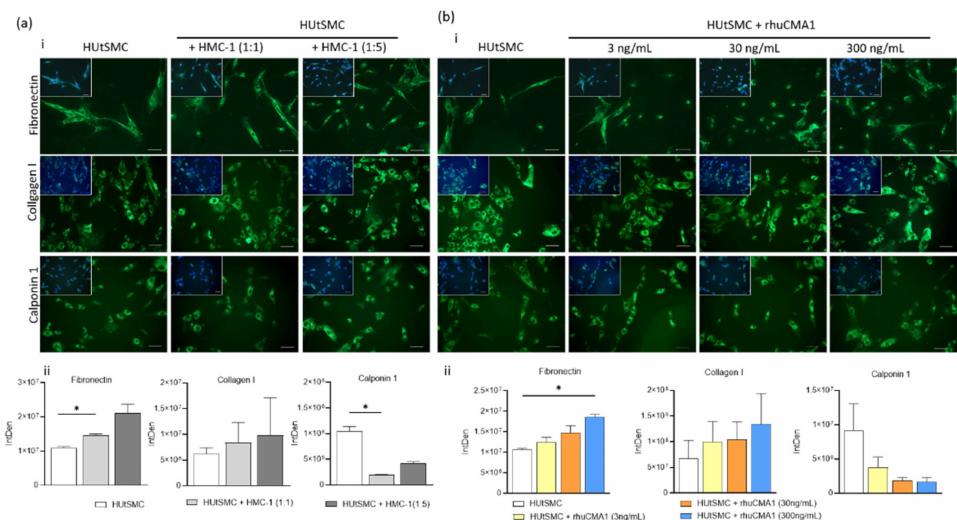
Figure 1. HMC-1 reduces calponin 1 and induces fibronectin expression, while rhuCMA1 induces fibronectin expression in HUtSMCs. Fibronectin, calponin 1 and collagen I expression in HUtSMCs after coculture with HMC-1 ( a ) at different cell-to-cell ratios (HUtSMC:HMC-1 ratio 1:1 or 1:5) or treatment with rhuCMA1 ( b ) at different concentrations (3 ng/mL, 30 ng/mL, 300 ng/mL) at 24 h was detected by immunofluorescence staining and analyzed with ImageJ software ( a ( ii ), b ( ii )). Representative images are shown in (( a ( i ), b ( i )) scale bar 200 µ m). The results are presented as a mean with SEM. Statistical analysis was performed using the one-way ANOVA test (* p < 0.05). HUtSMC: Human uterine vascular smooth-muscle cells; rhuCMA1: recombinant human